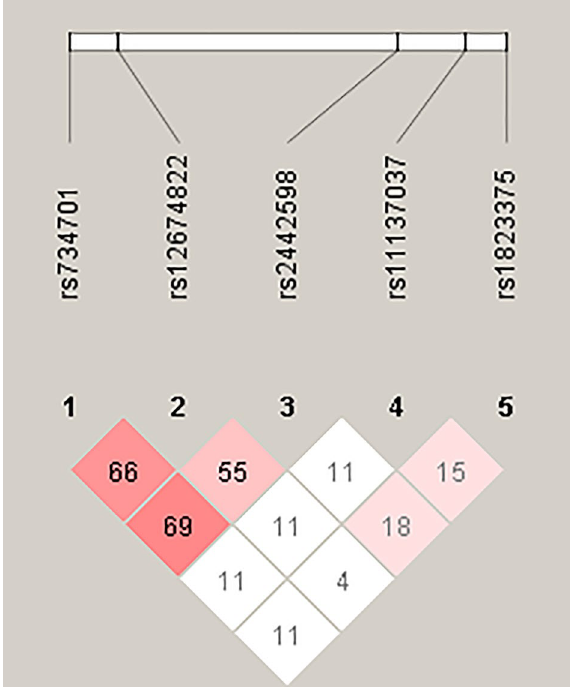
Figure 1. Linkage disequilibrium patterns of five single nucleotide polymorphisms in the ANGPT2